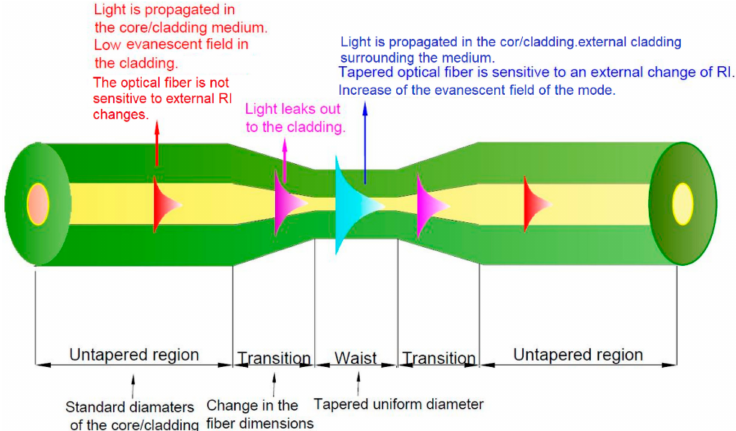
Figure 1. Graphic presentation of boundary conditions changes and modification of light propagation along the regions of a tapered optical